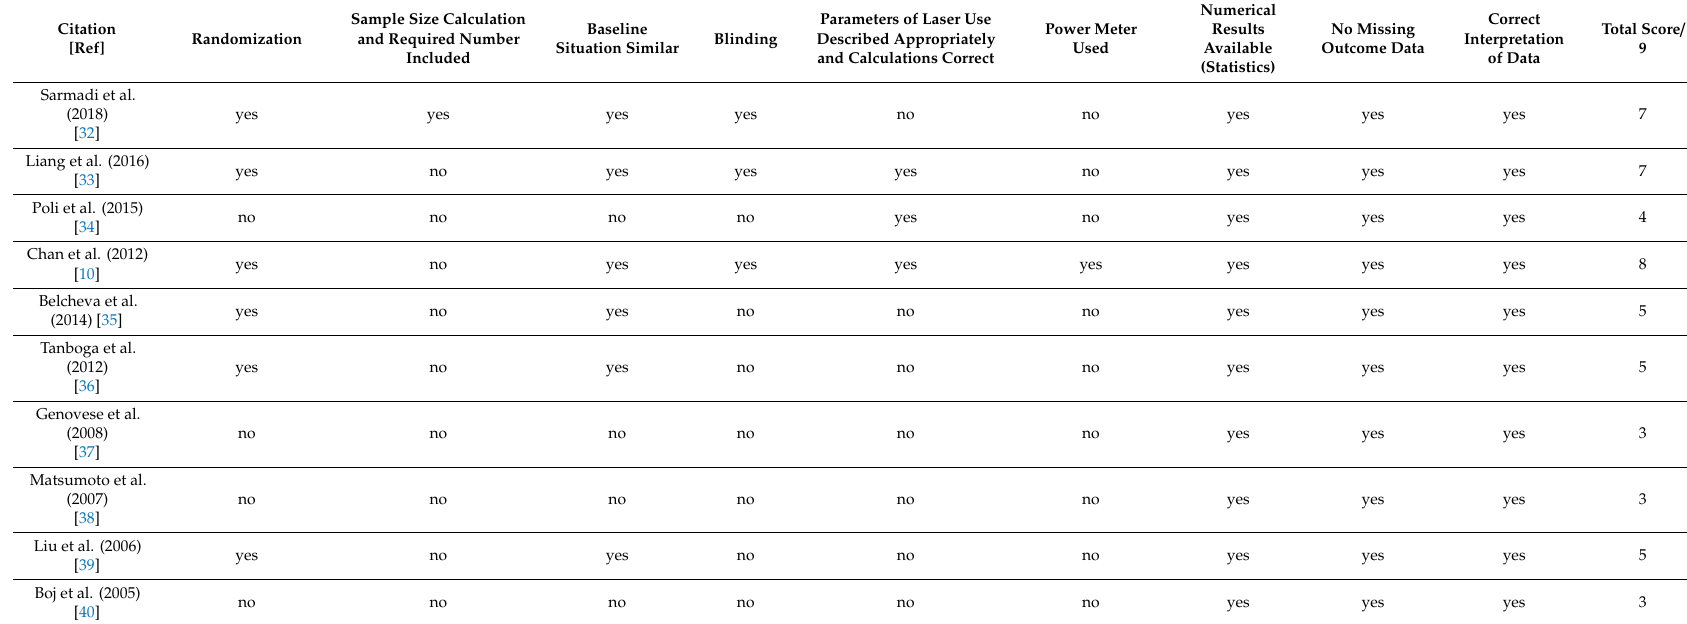
Table 2. Risk of bias evaluation of the included